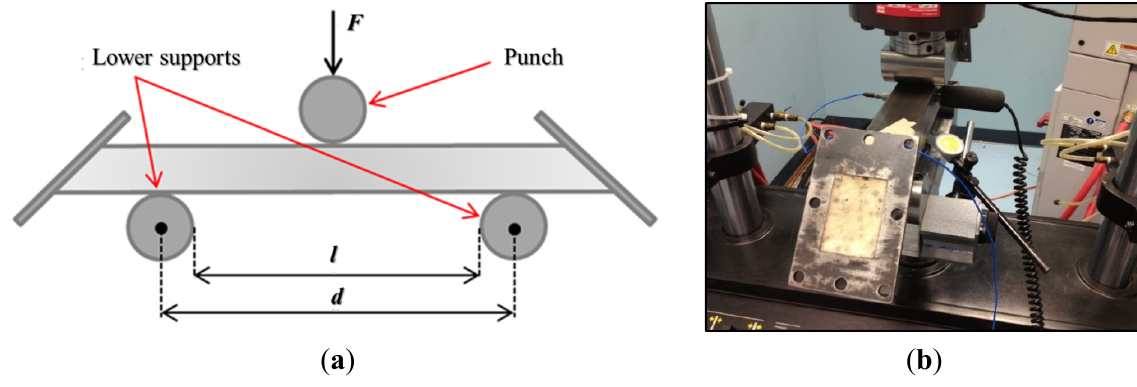
Figure 2. ( a ) Schematic representation of the three-point bending test ( l = 216 mm, d = 271 mm); ( b ) Position of the ultrasonic detector.